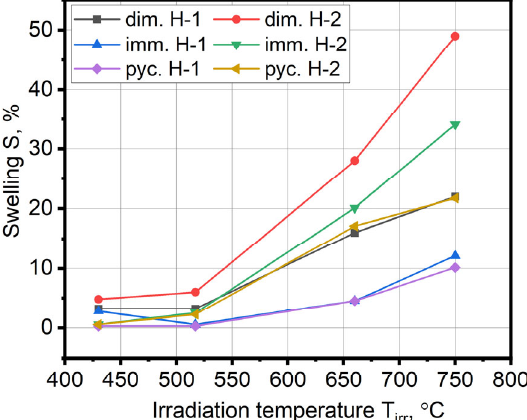
Figure 1. Dependence of swelling S of cast Be on irradiation temperature, reactor HFR, F = (0.73–1.82) · 10 22 cm − 2 (E > 1 MeV) (dim.—dimension, imm.—immersion, pyc.—pycnometry, H-1—HIDOBE-01, H ‐ 2—HIDOBE ‐ 02).